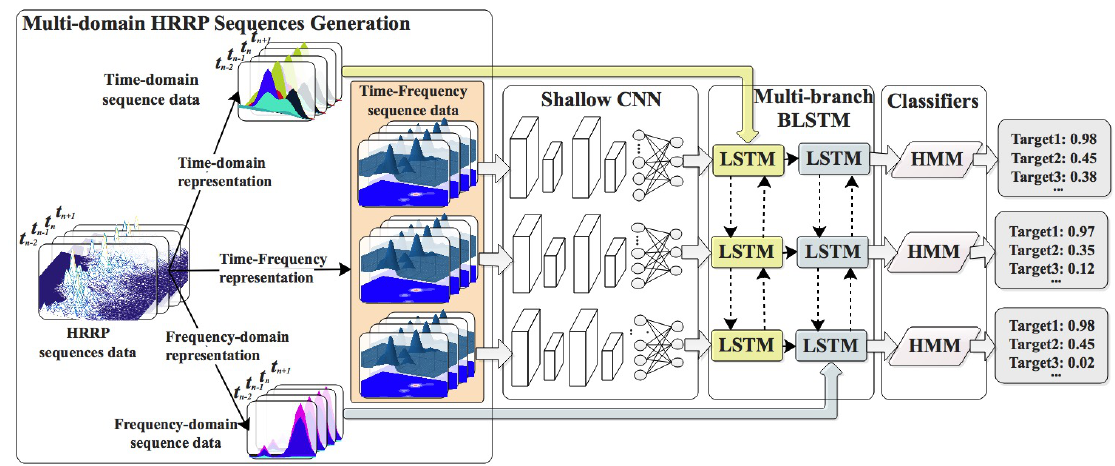
Figure 2. A flowchart of the proposed HRRP ATR framework based on BLSTM and